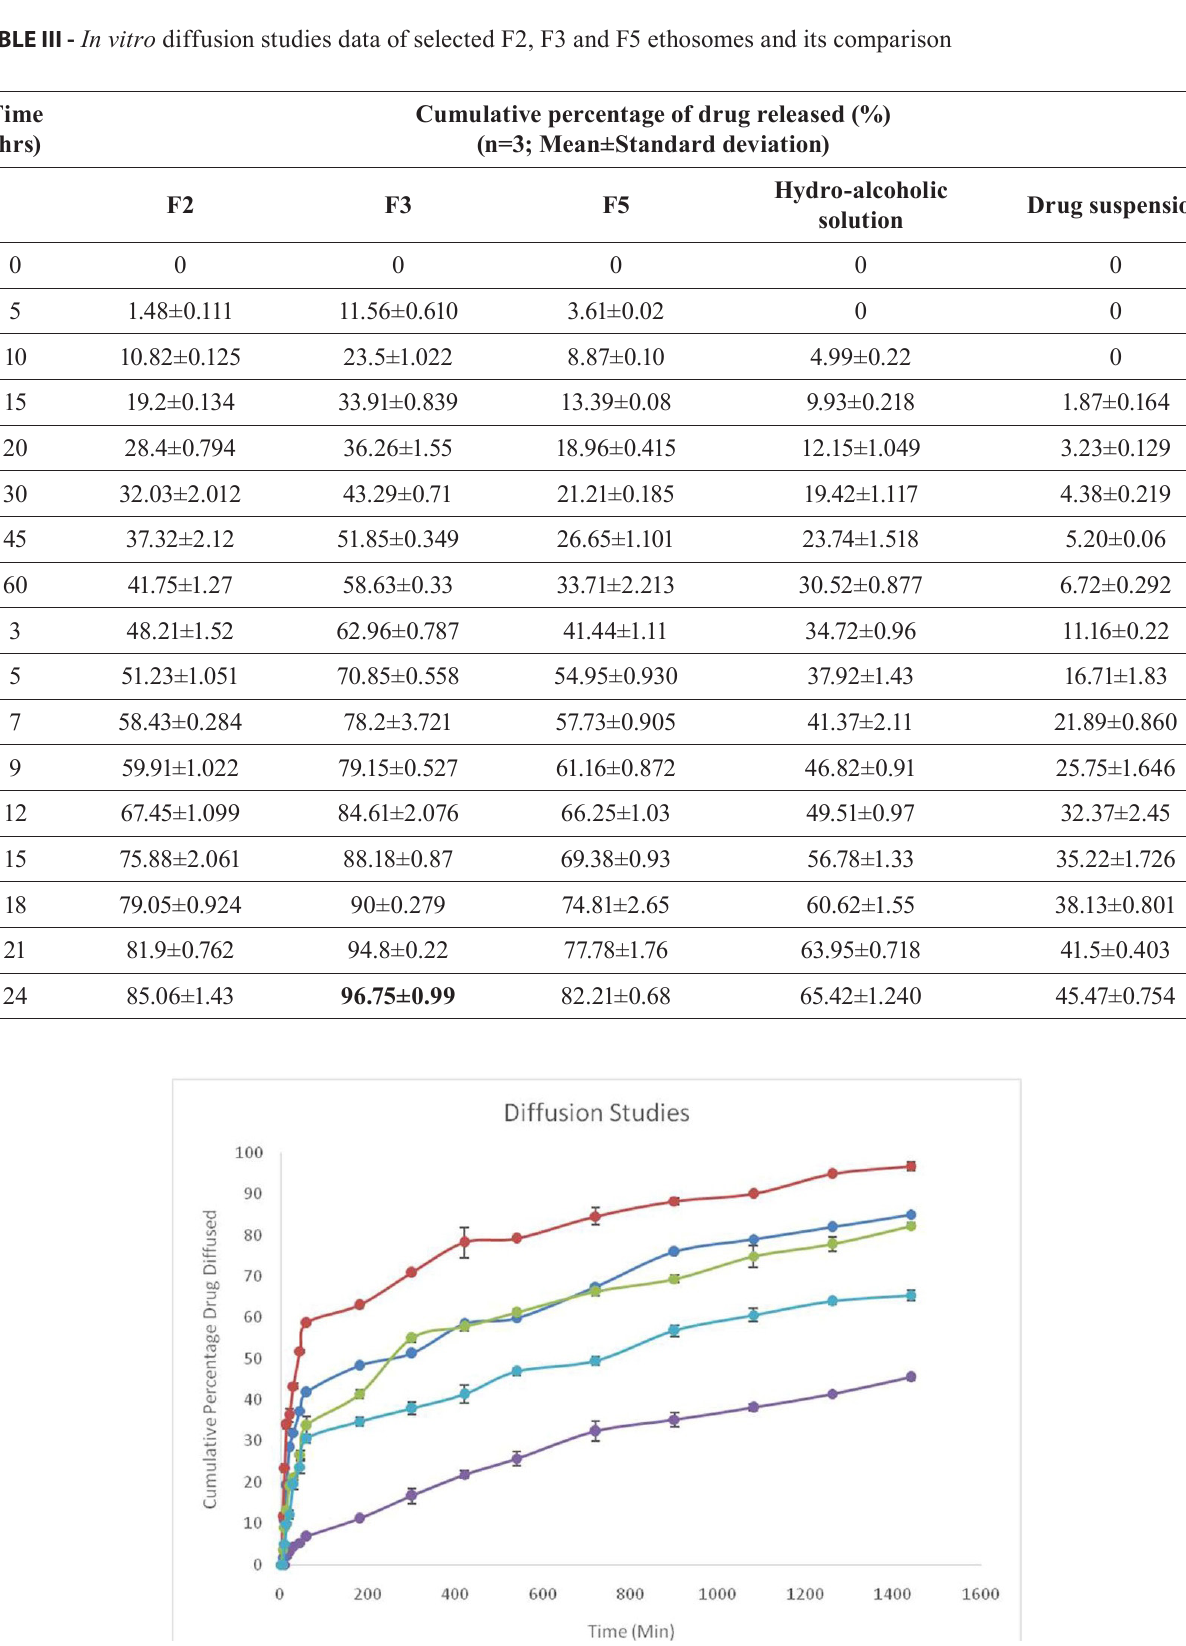
FIGURE 3 - : Invitro diffusion studies data of selected F2, F3 and F5 ethosomes and its